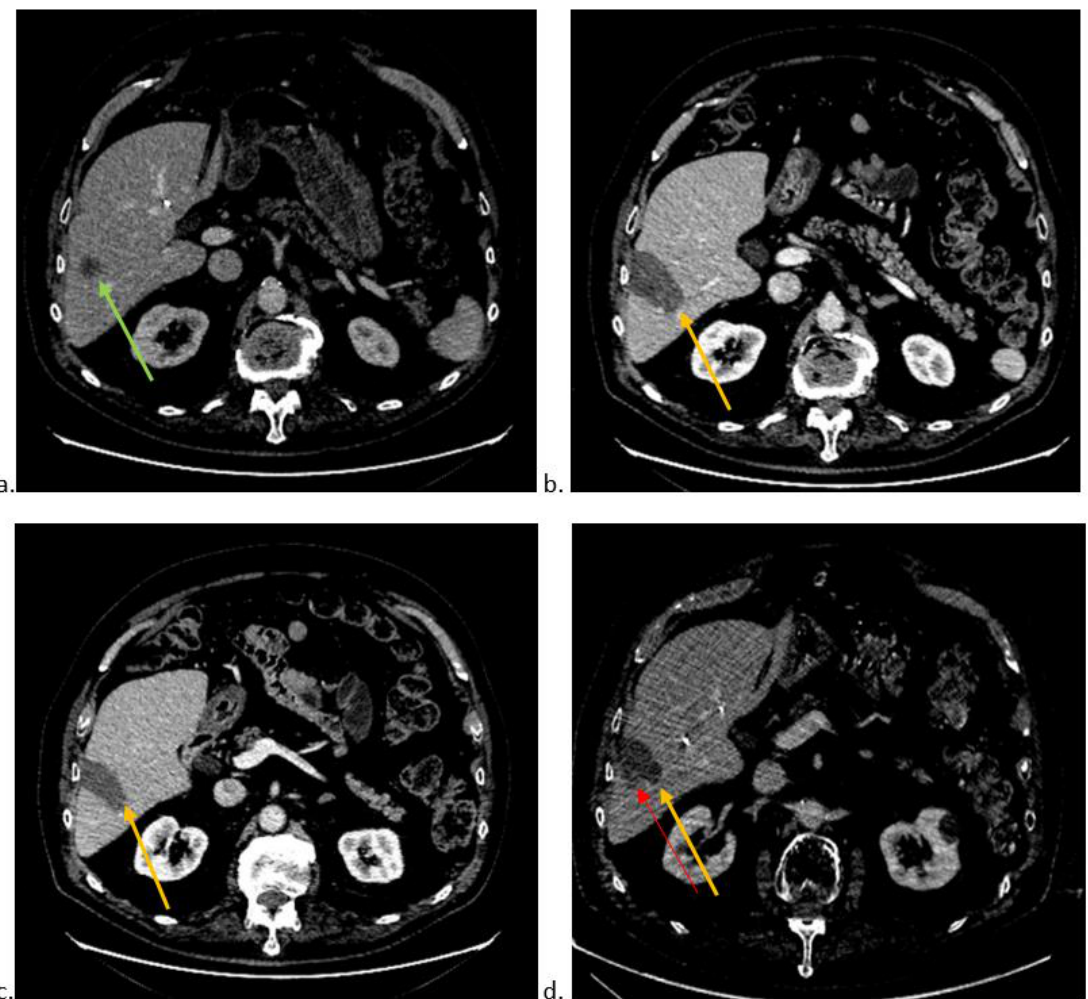
Figure 1. ( a ). Axial CT-scan image at portal phase showing colorectal liver metastasis (green arrow) in segment VI. ( b ). Axial CT-scan image at portal phase showing technical success of thermoablation (orange arrow) with no residual tumour. ( c ). Axial CT-scan image at portal phase of the lowest part of thermoablation area (orange arrow). ( d ). Axial CT-scan image at portal phase showing local recurrence (red arrow) at the edge of the thermoablation site (orange arrow). There was no significant difference in the rate of local recurrence between liver segments ( p = 0.35). However, the local recurrence rate was 50% in segment I. The comparison of lesion characteristics by recurrence status is detailed in Table 3.